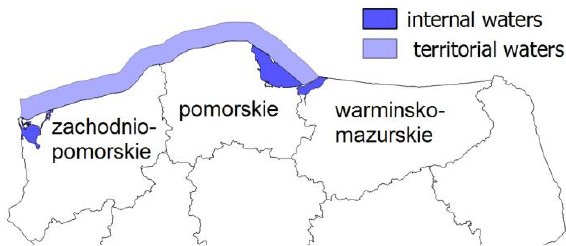
Figure 6. Provinces at the Baltic Sea. Source: prepared by the author based on State Register of Borders.